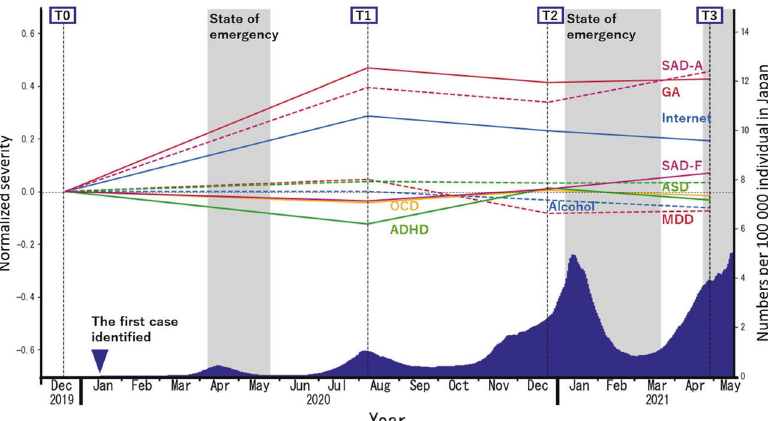
Fig. 2 Trajectories of psychiatric scores in the study population ( N = 2274). The blue area under the curve represents a 15-day moving average of daily new cases of COVID-19 per 100,000 Japanese residents. GA general anxiety as measured with the STAI-Y, SAD-A avoidance aspects of social anxiety disorder as measured using the LSAS-A, Internet internet-related problems as measured with the CIUS, ASD autism as measured with the AQ, SAD-F fear aspects of social anxiety disorder as measured using the LSAS-F, OCD obsessive-compulsive disorder as measured using the OCI, ADHD attention-de fi cit and hyperactivity disorders as measured with the ASRS, Alcohol alcohol-related problems as measured with the AUDIT, MDD major depressive disorder as measured using the